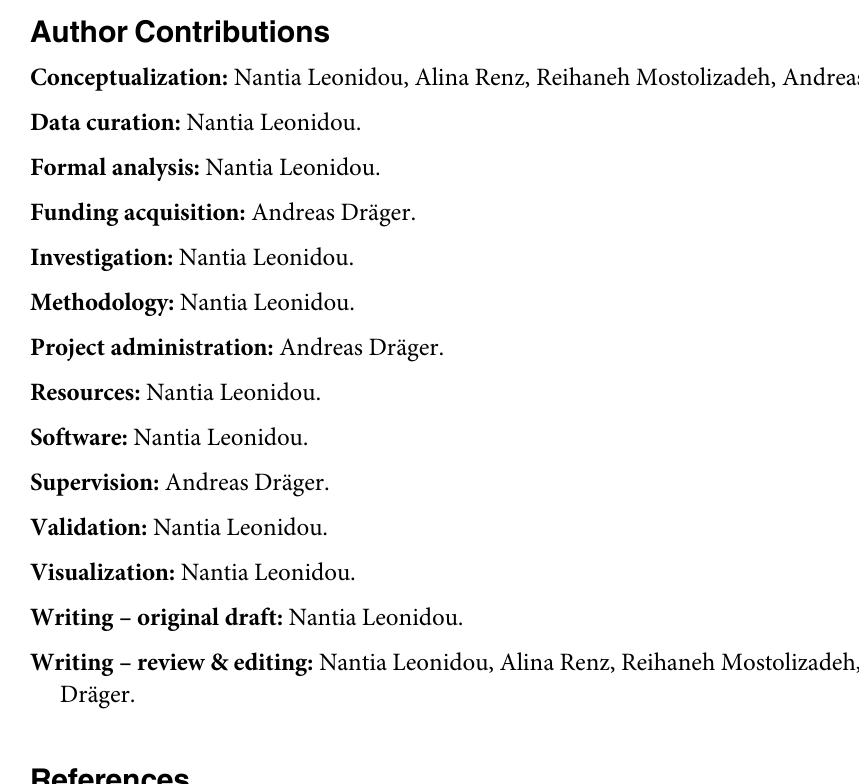
S7 Table. Five-number summary of reaction fluxes in host and virus. The summary consists of five values: minimum, first quartile (25 th percentile), median (50 th percentile), third quartile (75 th percentile), and